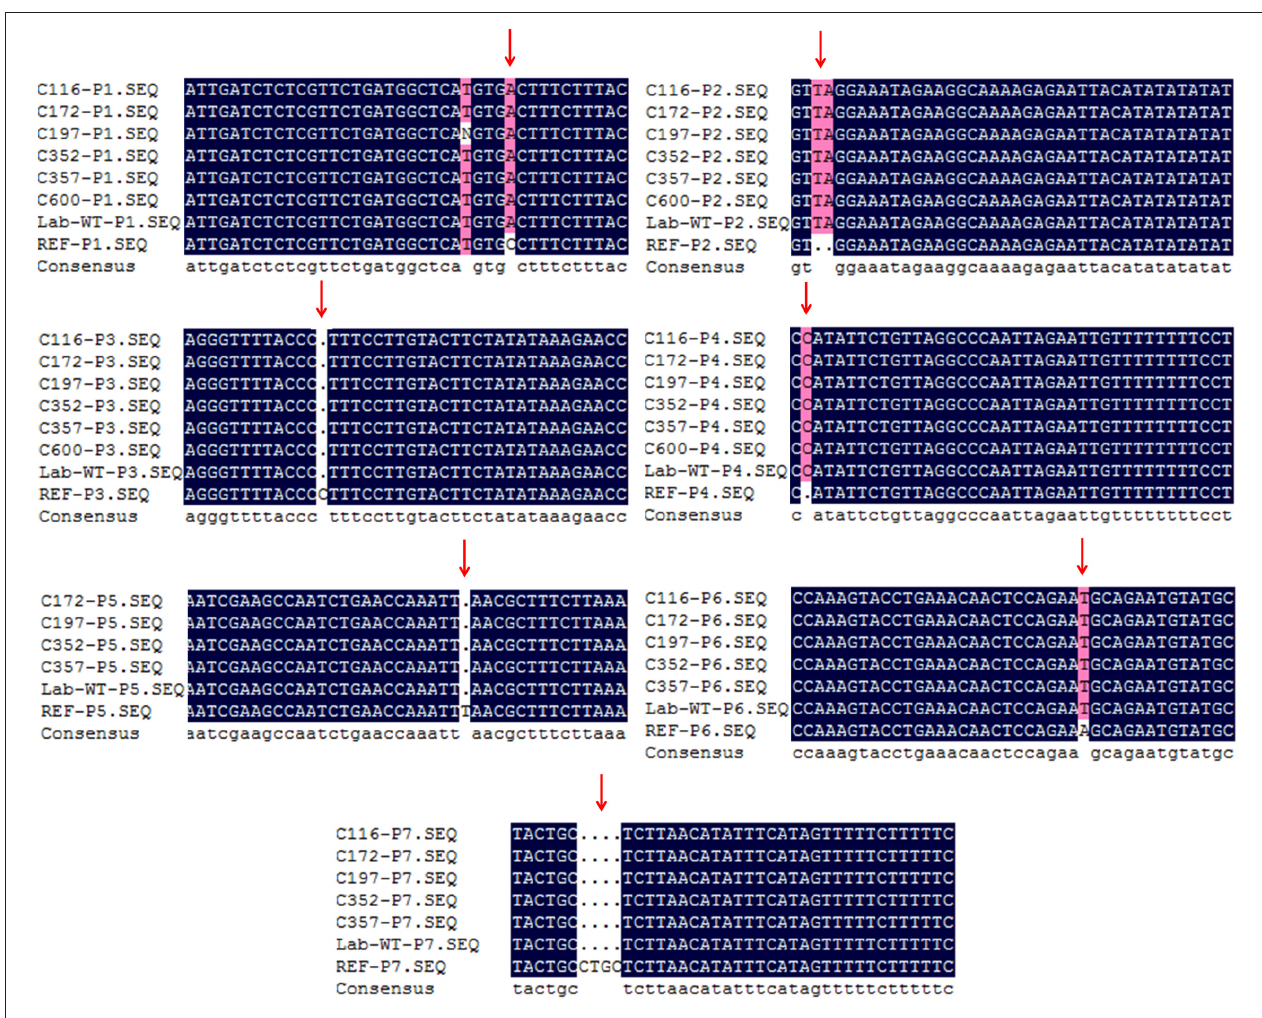
FIGURE 3 | Verification of background mutations by Sanger sequencing. The REF denotes the Col-0 reference genome. The sequence alignment of different primers (P1–P7) from C116, C172, C197, C352, C357, Lab-WT and reference were shown with different colors according to their sequence homology. Pink highlights the sequence which are different from the reference genome, the dot indicates deletions in the corresponding position.